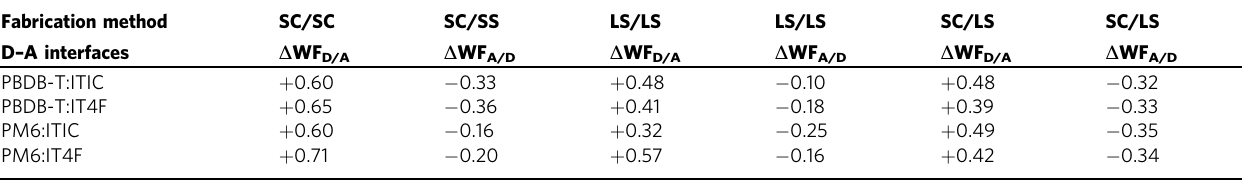
Table 1 Summary of the Δ WF values for donor (D) – acceptor (A) interfaces based on different fabrication methods. Fabrication